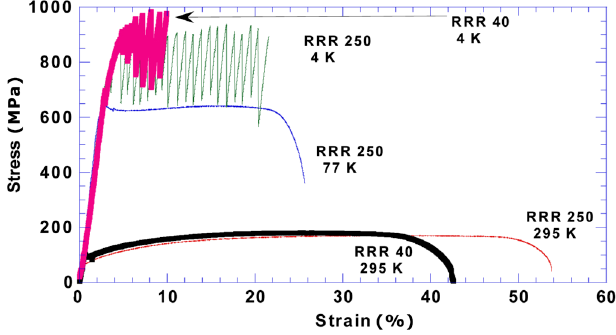
FIG. 4. (Color) Temperature dependence of Nb flow stress, used with permission from AIP